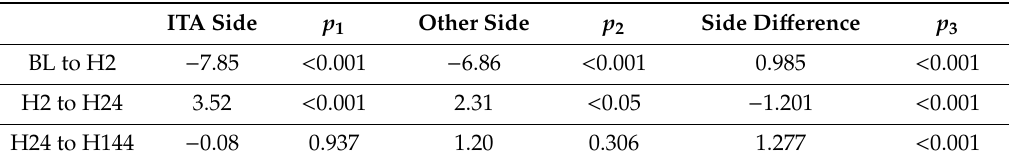
Table 2. Different course of SNR at each side of the chest wall during the study. p 1 for ITA side; p 2 for the other side; p 3 for the difference in the course of between both sides.